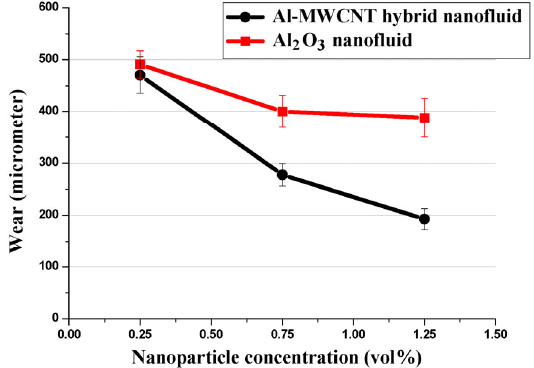
Fig. 9 Wear measurement for alumina and Al-MWCNT hybrid nanofluid samples at different concentrations.